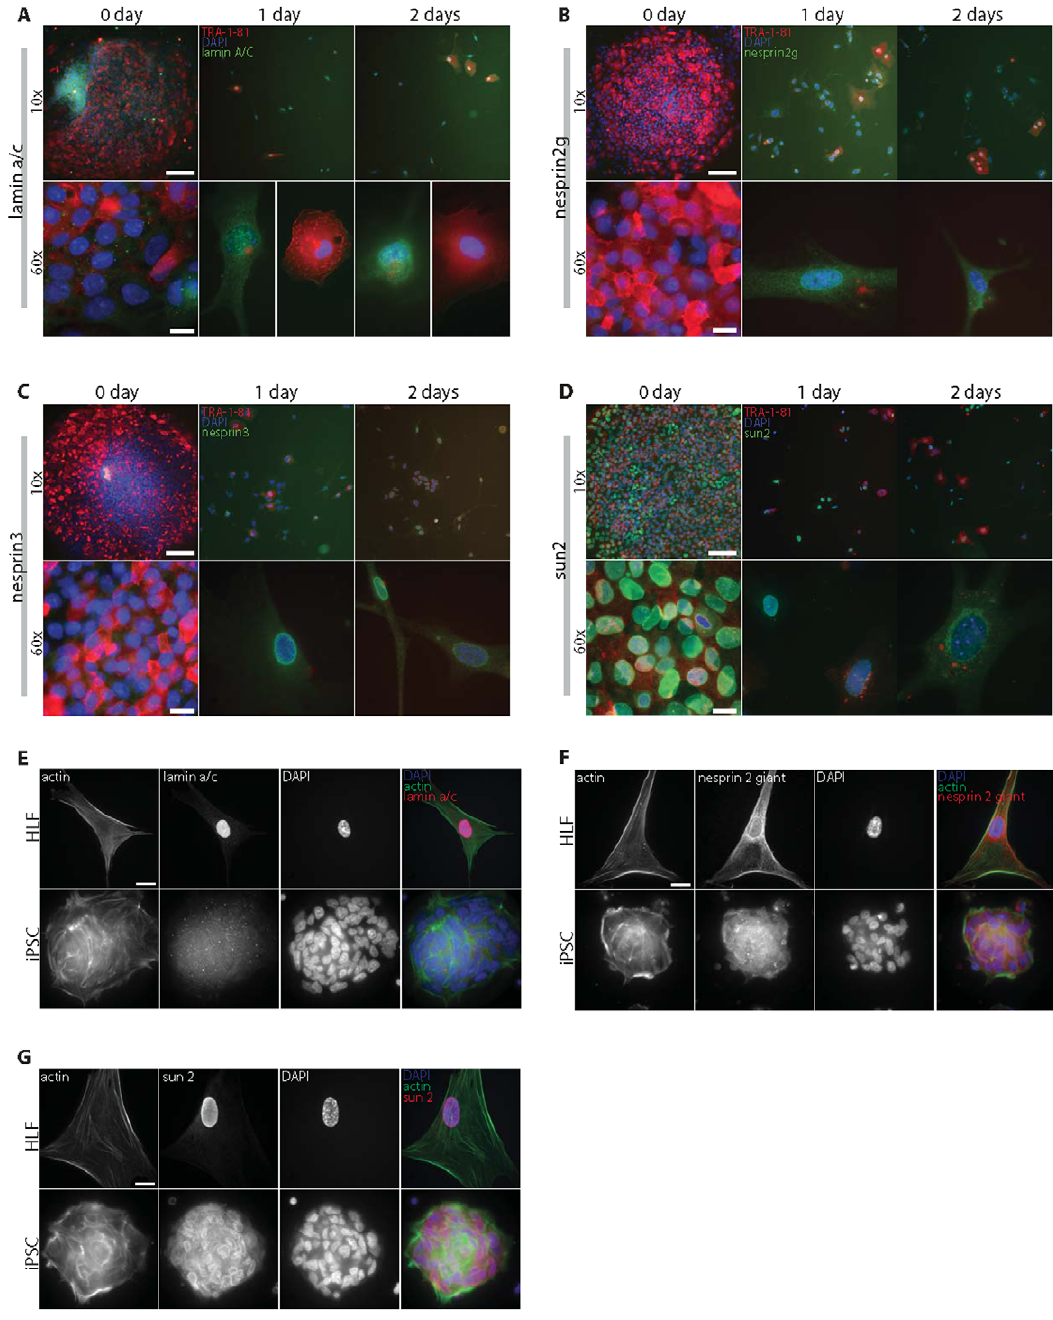
Figure 5. Status of Lamin A/C and LINC complexes in hESCs and iPSC during differentiation. A–D. Low- (10 6 , top panels) and high- magnification (60 6 , bottom panels) views of the organization of lamin A/C (A) and LINC complex components Nesprin2 giant (B), Nesprin3 (C), and Sun2 (D) at or near the nuclear envelope in undifferentiated hESCs and hESCs one and two days after switching to differentiation conditions. Cells were stained for nuclear DNA (DAPI), actin, TRA-1-81, and with antibodies against human lamin A/C, Nesprin2 giant, Nesprin3, and Sun2, as indicated, and visualized by immunofluorescence microscopy. Scale bar for 10 6 micrographs, 100 m m; Scale bar for 60 6 micrographs, 20 m m. E–G. Immunofluorescence micrographs showing the organization of actin and lamin A/C (E), LINC complex components Nesprin2 giant (F) and Sun2 (G) at the nuclear envelope of parental HLFs (top panels) and IPSCs (bottom panels). Scale bar, 20 m m. doi:10.1371/journal.pone.0036689.g005 Nuclei in undifferentiated hESCs were both multi-lobulated (i.e. ating hESCs coincided with a progressive enhancement of nuclear with more than one lobe) and elongated; while nuclei in shape regularity, as measured by progressively higher nuclear differentiating hESCs typically had a smooth morphology and a shape factor (Fig. 6A) and progressively lower fraction of multi- round shape (Fig. 6, A–E). Nuclear morphometry indicated that lobulated nuclei (Fig. 6C). Moreover, while undifferentiated the progressive formation of perinuclear actin caps in differenti- hESCs showed a wide distribution of nuclear shape factors, this